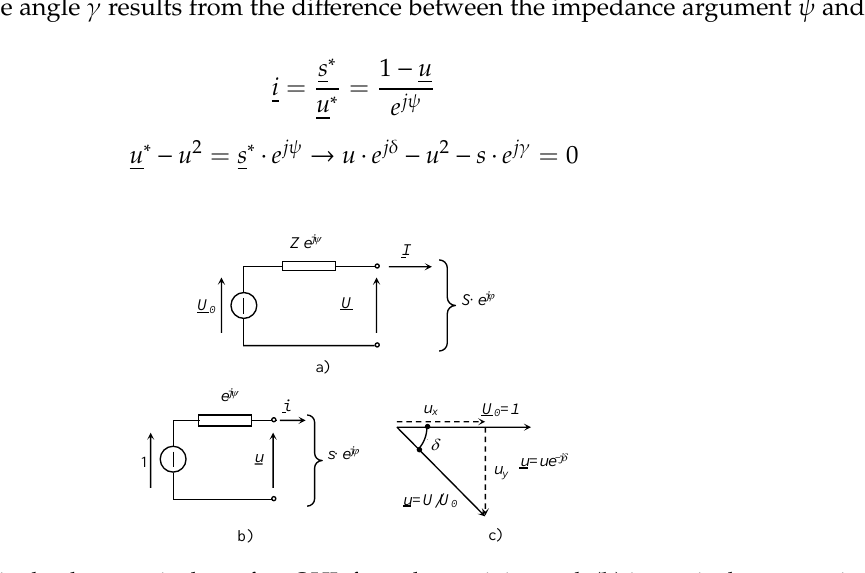
Figure 9. ( a ) Single-phase equivalent of an OHL from the receiving end, ( b ) its equivalent per unit representation, and ( c ) vector diagram of the voltage.